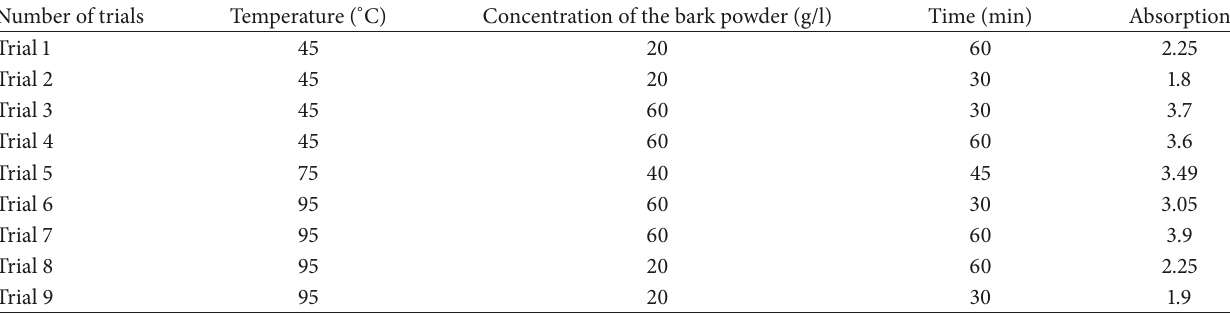
Table 2: Absorption values of dye solution from bark of Cassia singueana .